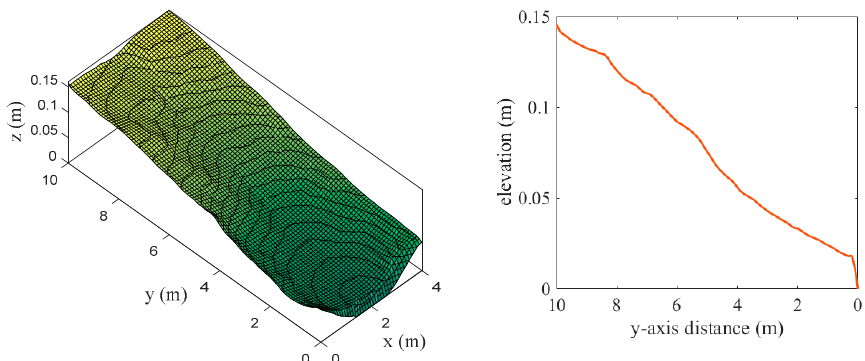
Figure 7. ( Left ) Elevation of the tested basin in Thies, Senegal. ( Right ) Bottom profile along 𝑦 -axis at 𝑥 = 2 m.